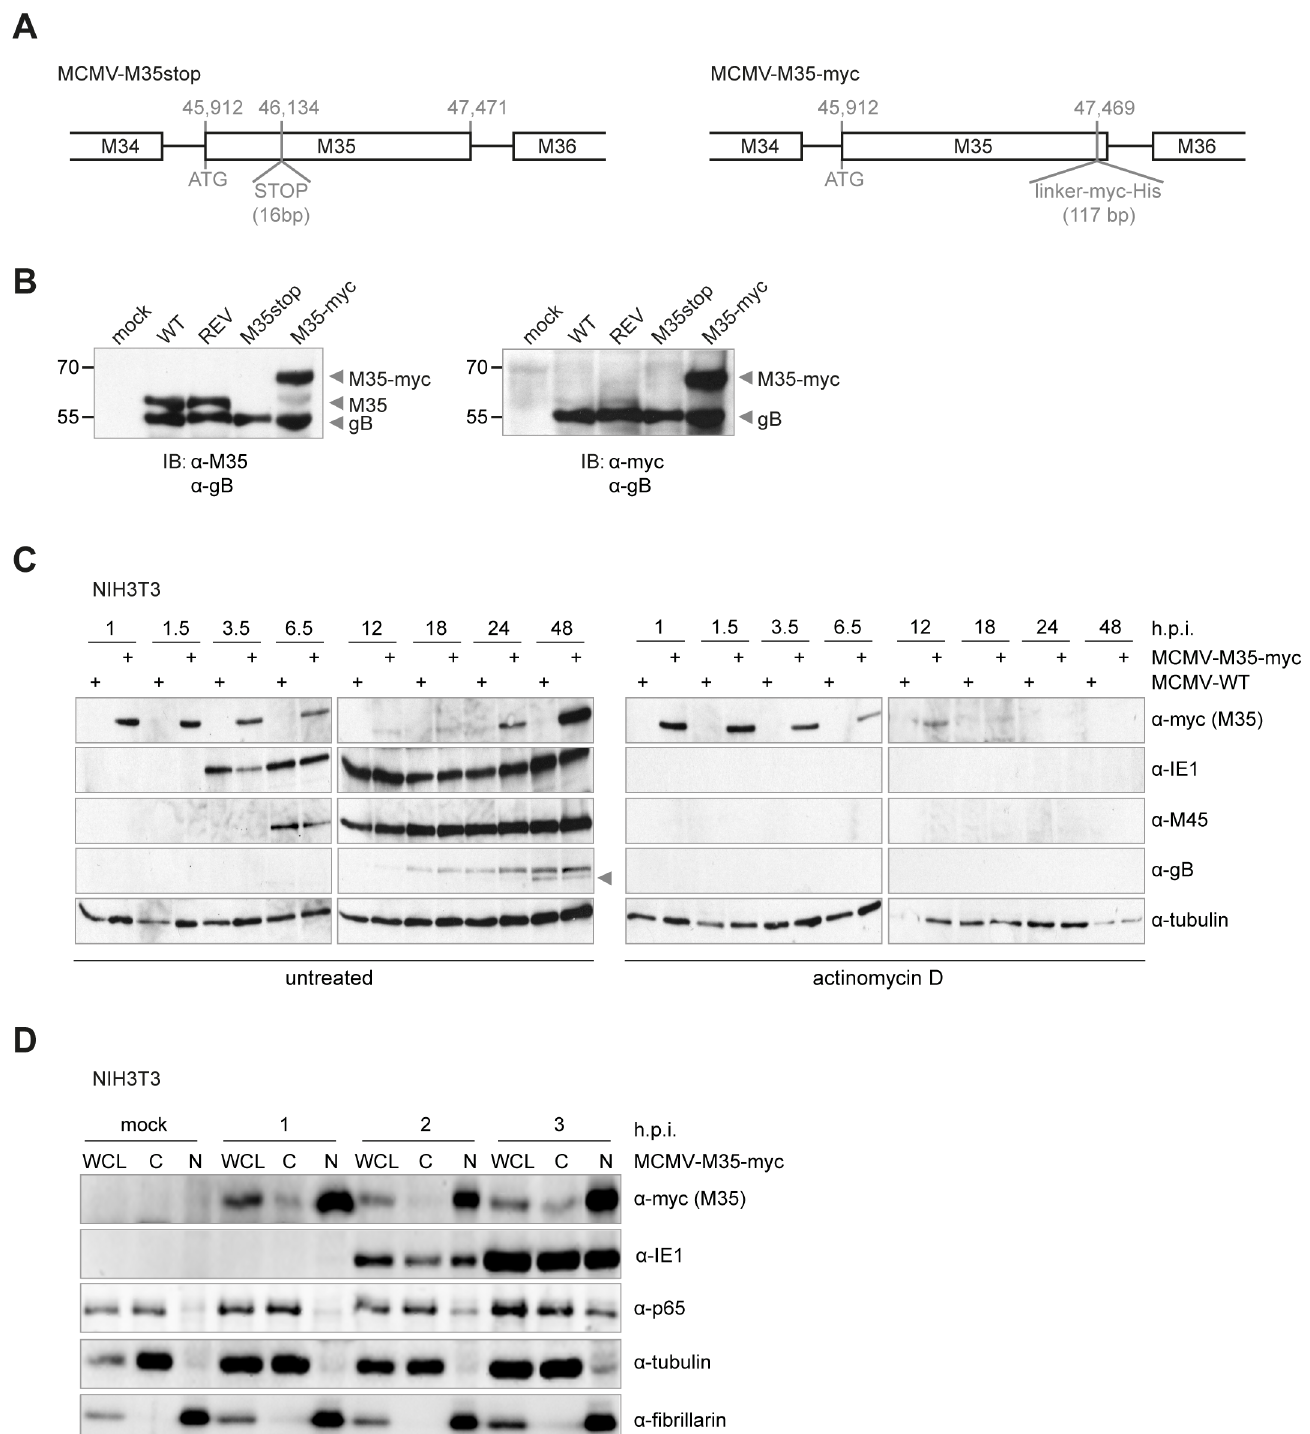
Fig 6. Upon MCMV infection, delivery of tegument M35 to the nucleus precedes translocation of p65. (A) Schematic representation of recombinant MCMV constructed for this study. Numbers correspond to nucleotidelocationsin the genomeof MCMV strain Smith (accession #GU305914). Left panel:MCMV-M35stop. ATG representsthe start codonof M35 and STOP denotes the introducedstop cassette. Right panel: MCMV-M35-myc. Linker-myc-His represents an 18 amino acid linker fused to a 10 amino acid myc-tag and a 6x Histidine tag. (B) Nycodenz-purified virus preparations of MCMV-WT (WT), MCMV-M35stop-REV (REV), MCMV-M35stop (M35stop) and MCMV-M35-myc (M35-myc) adjustedto 5 x 10 4